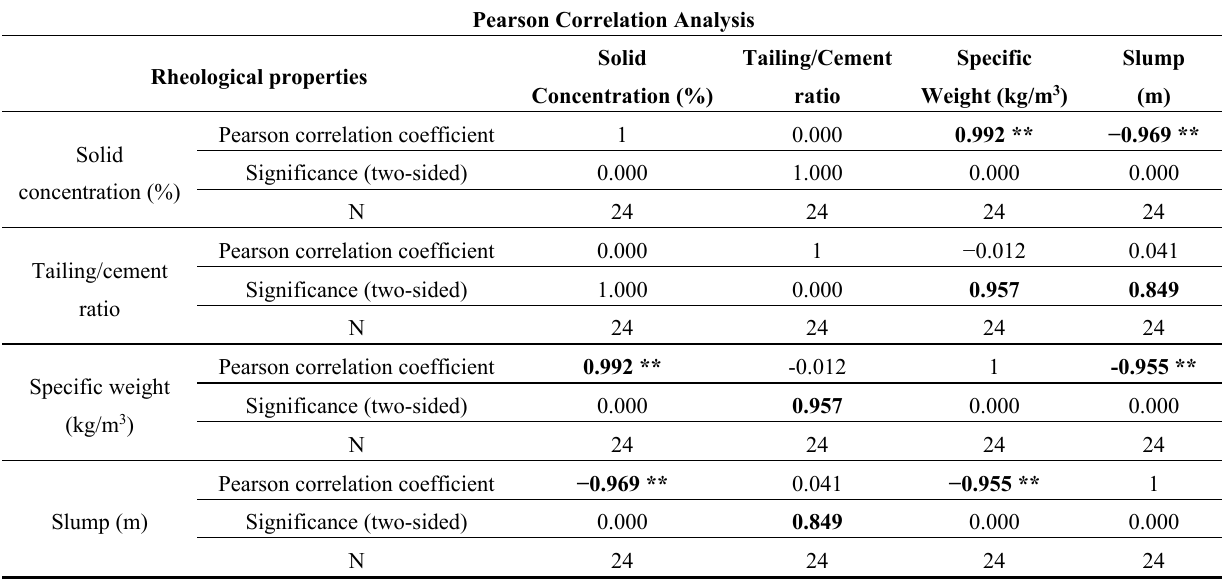
Table 7. A Pearson correlation analysis of factors influencing rheological properties. Pearson Correlation